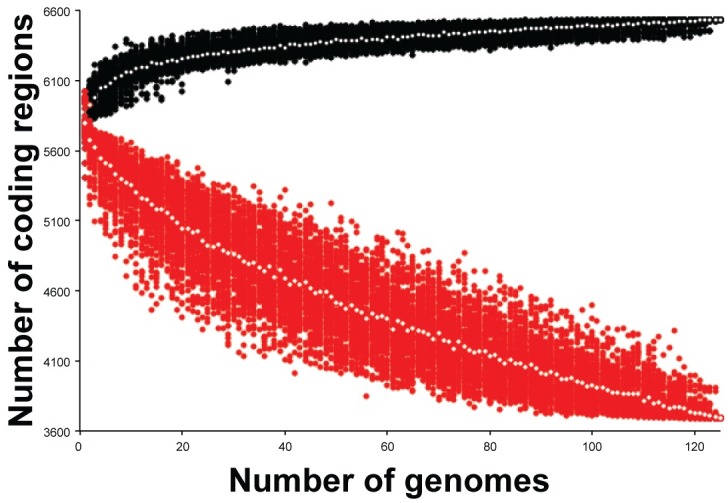
Pan and core genome dynamics.Size of pan (black) and core (red) genome with increased random sampling of genomes show a closed genome and the reduced size of some genomes due to genomic deletions.